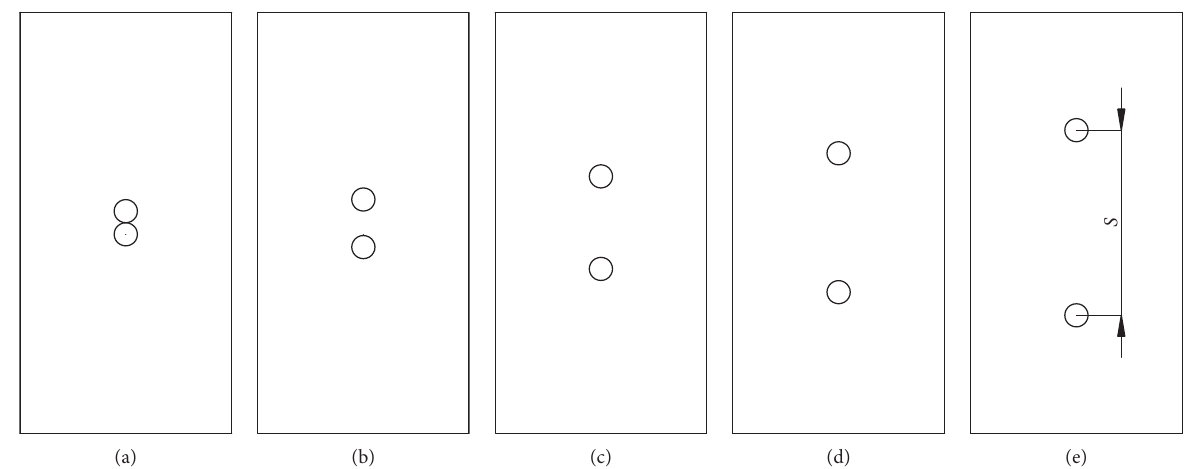
Figure 5: Numerical test samples with different boreholes spacing. The S of (a), (b), (c), (d), and (e) are 1 D , 2 D , 4 D , 6 D, and 8 D , respectively.